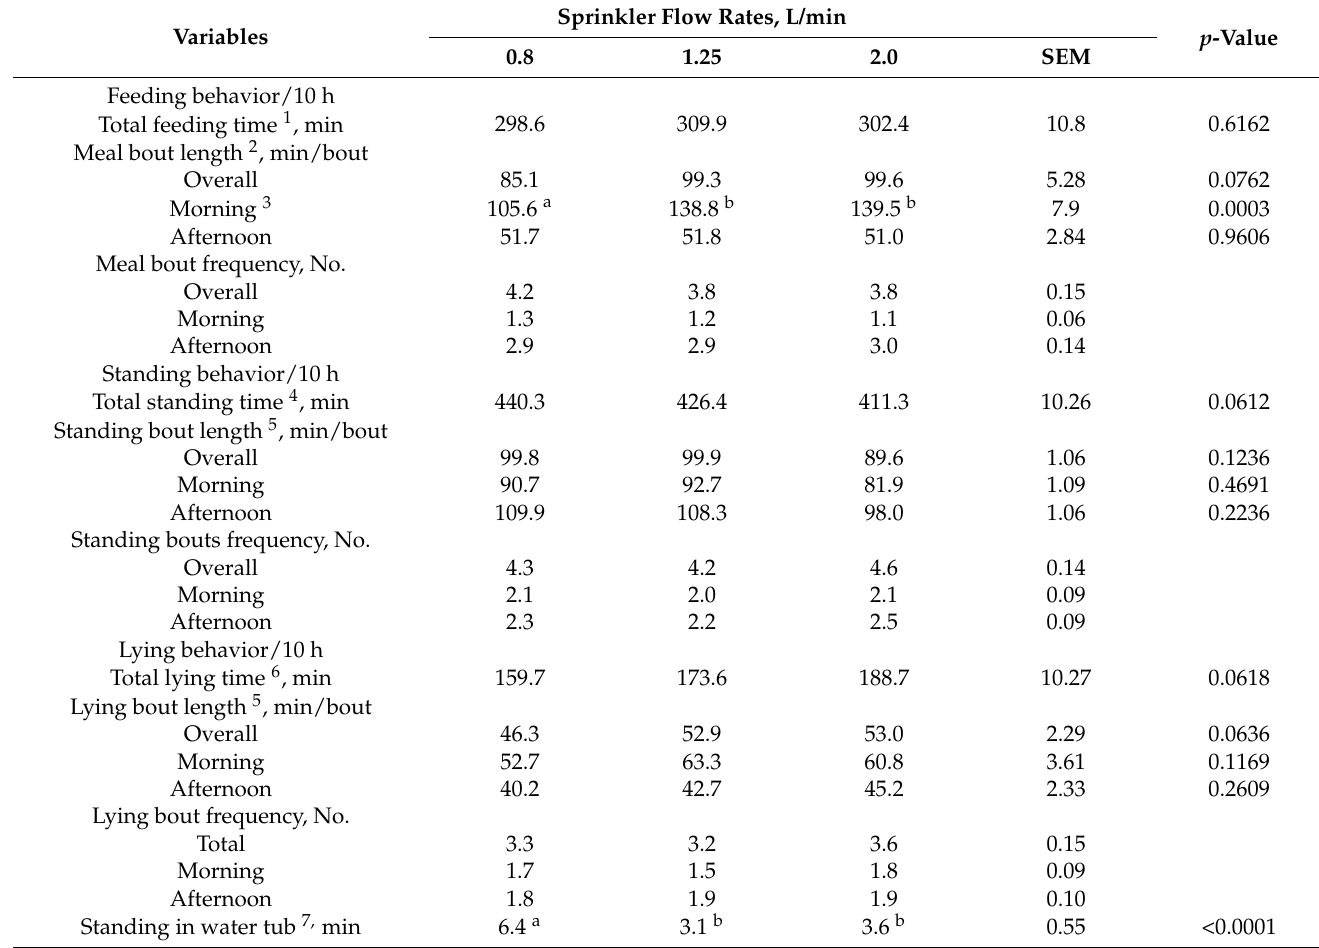
Table 5. Effect of sprinkler flow rate on behavioral responses of Nili Ravi buffaloes ( n = 18) during summer. Sprinkler Flow Rates, Variables